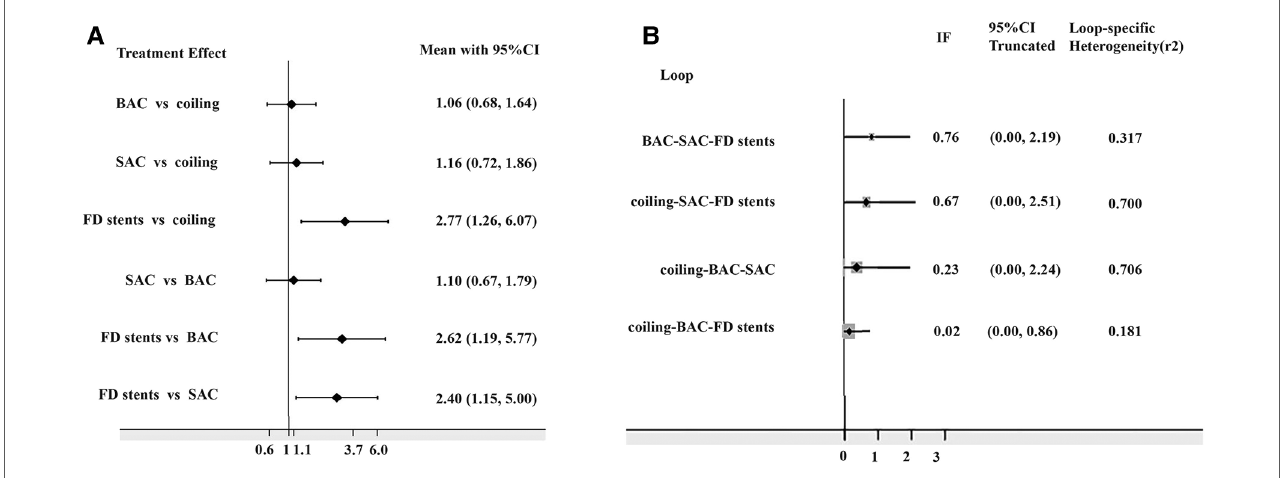
FIGURE 3 ( A ) Odds risks of different endovascular treatments on DWI-positive lesions; ( B ) inconsistency plot for direct and indirect comparisons. DWI, diffusion- weighted imaging; BAC, balloon-assistant coiling; SAC, stent-assistant coiling; FD stents, fl ow-diverting stents; CI, con fi dence interval; IF, inconsistency